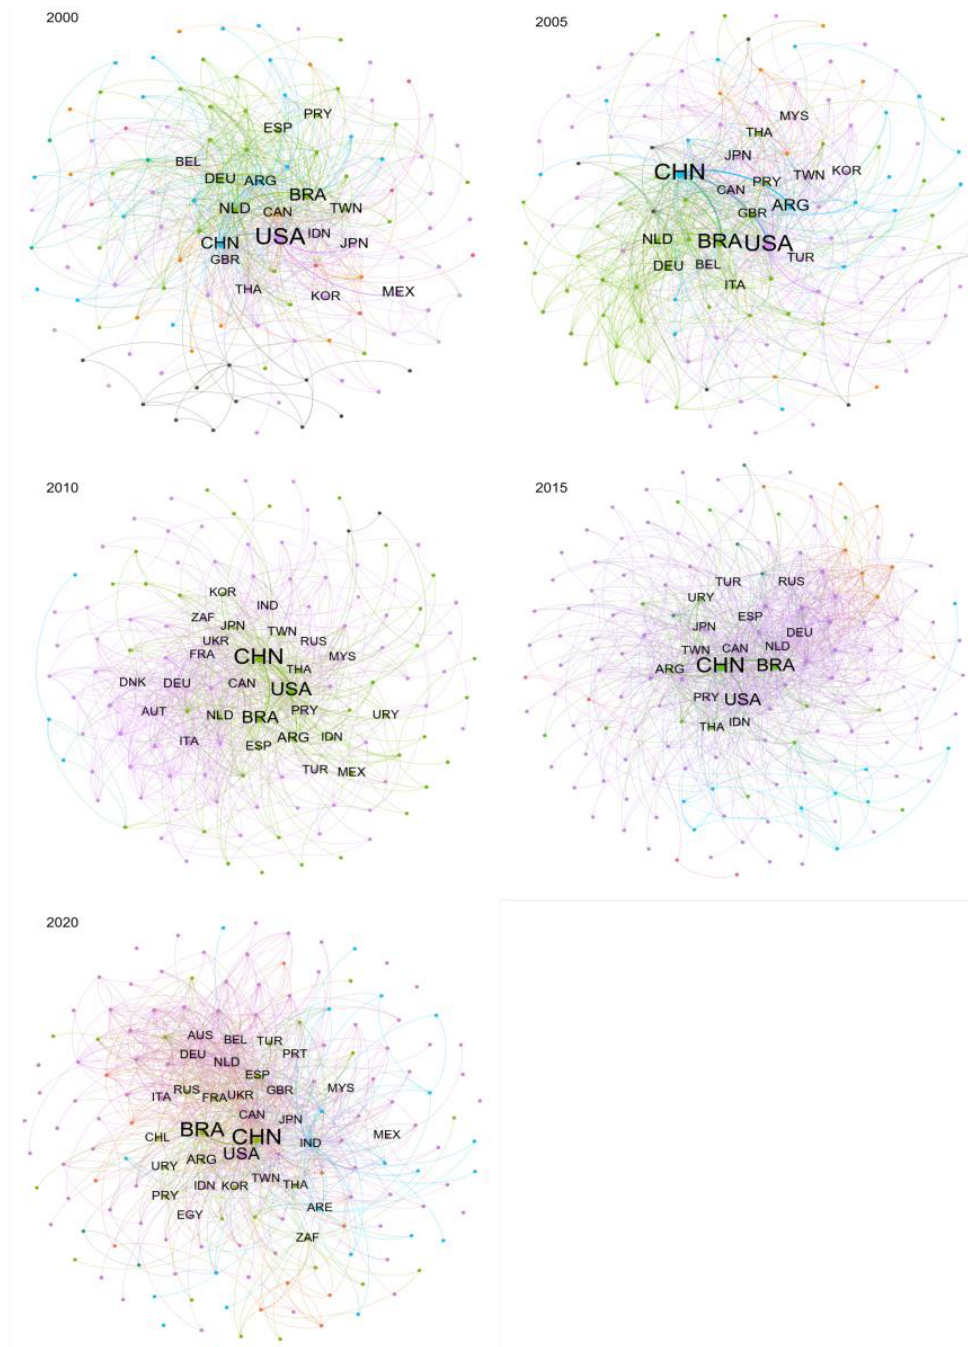
Figure 2. Global soybean trade network in 2000, 2005, 2010, 2015, and 2020 (data source: FAO). Note: nodes represent countries or regions, and their size are proportional to the trade volumes. The edges represent the weight of the soybean trade volume, and their widths are positively correlated to the bilateral trade volumes. Different colors of nodes and edges represent different communities in the GSTN. The countries in the same community had closer trade relationships. Trade relations between countries in the same community are much closer than countries in different communities.